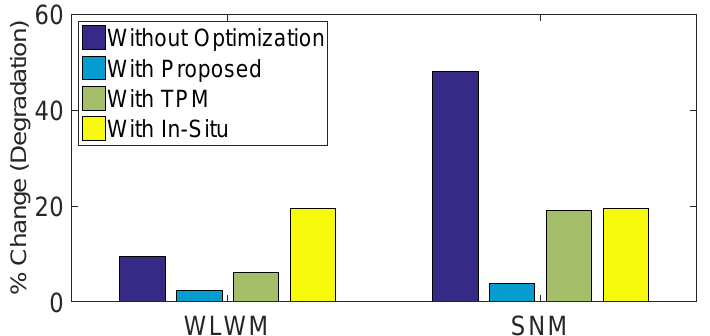
Figure 20. Comparison of stability and write performance failure for proposed and existing techniques In-Situ [9] and (TPM)